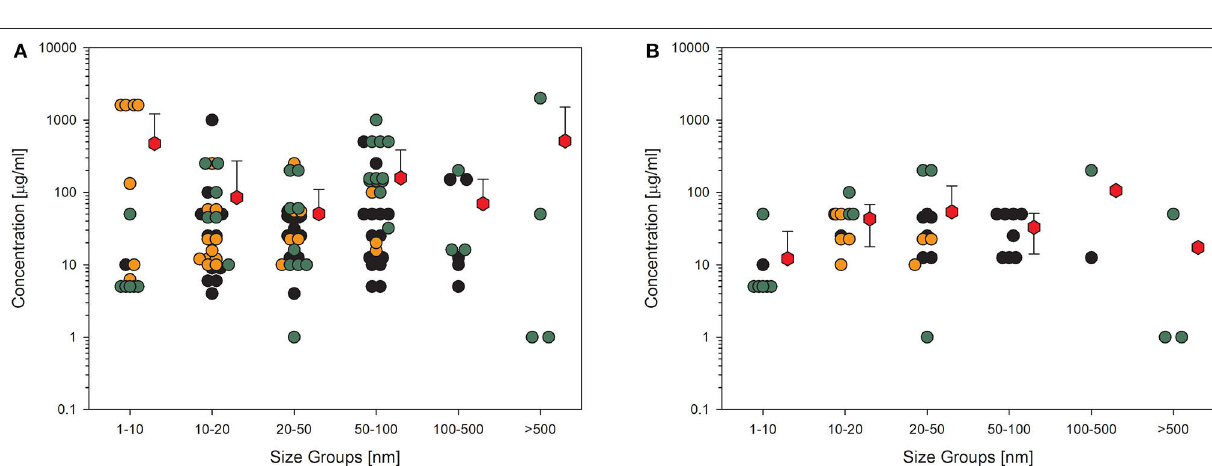
FIGURE 5 | Results of the evaluation of in vitro studies on cytokine production in cells treated with amorphous silica. Data have been collected in six size groups for primary particle size as indicated on the abscissa. (A) All available datasets; (B) datasets from studies with high-quality scores of 0.8 or 1. Details are as those shown in Figure 2 . Data points taken from the references are given in the Supplementary Material